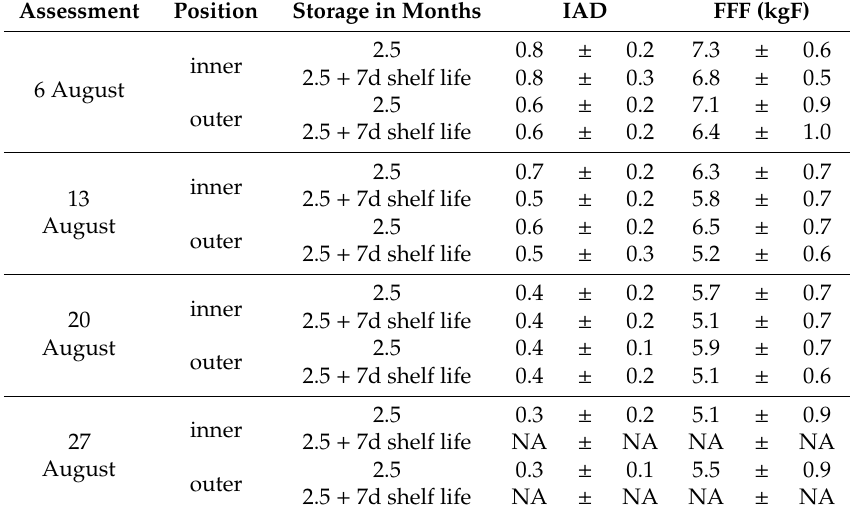
Table A4. Post-storage values of IAD and fruit flesh firmness-FFF (mean and standard deviation) of cv. ‘Gala Buckeye’ apples harvested at di ff erent maturity stages.